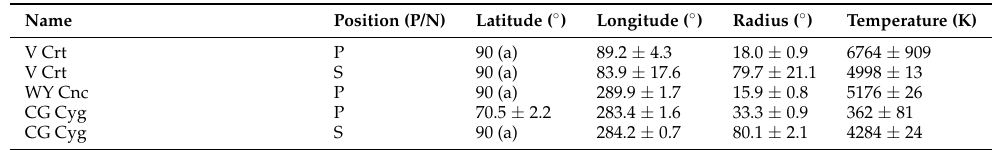
Table 6. Spot parameters of three eclipsing